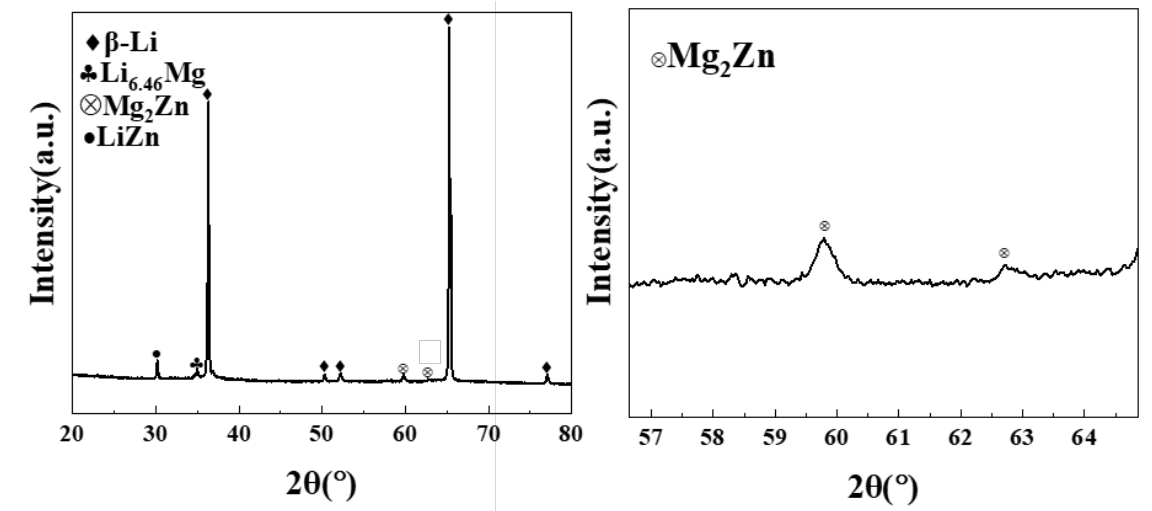
Figure 4. XRD images of cryogenic MD-rolled alloy.